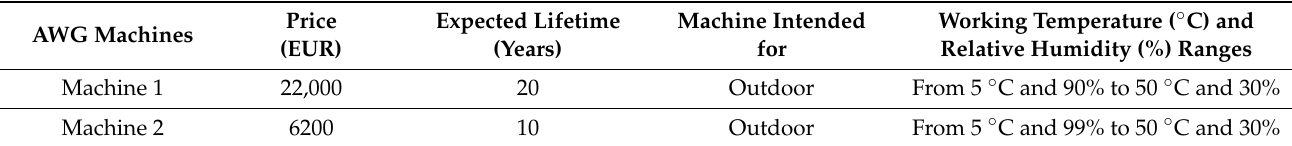
Table 2. Main features of AWG machines.